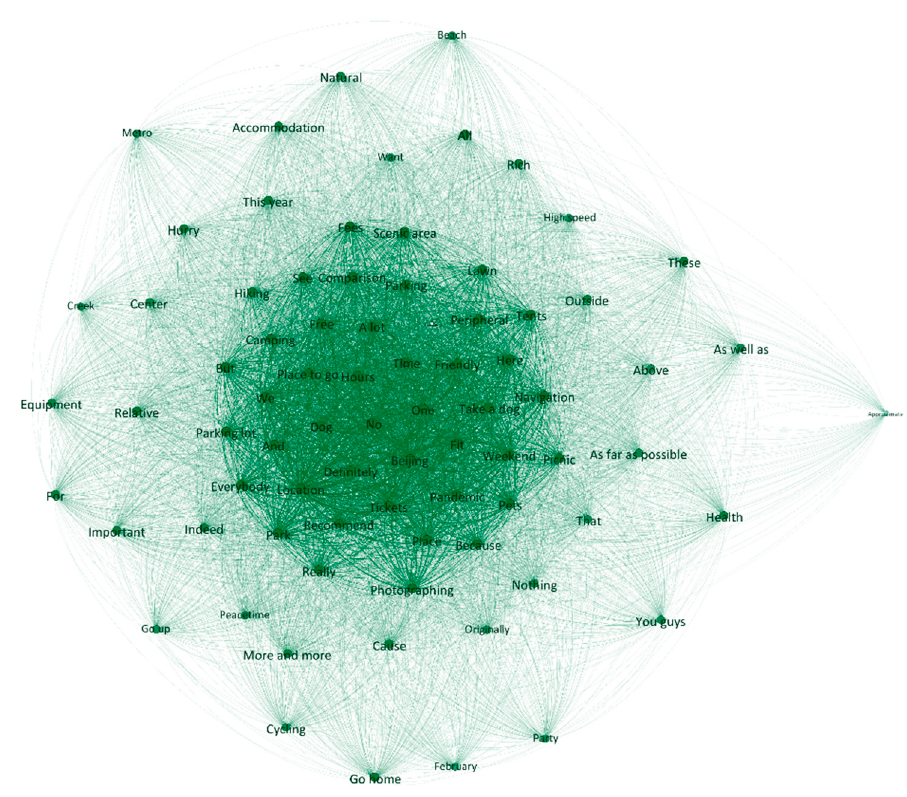
Figure 7. Semantic network diagram (during the outbreak).